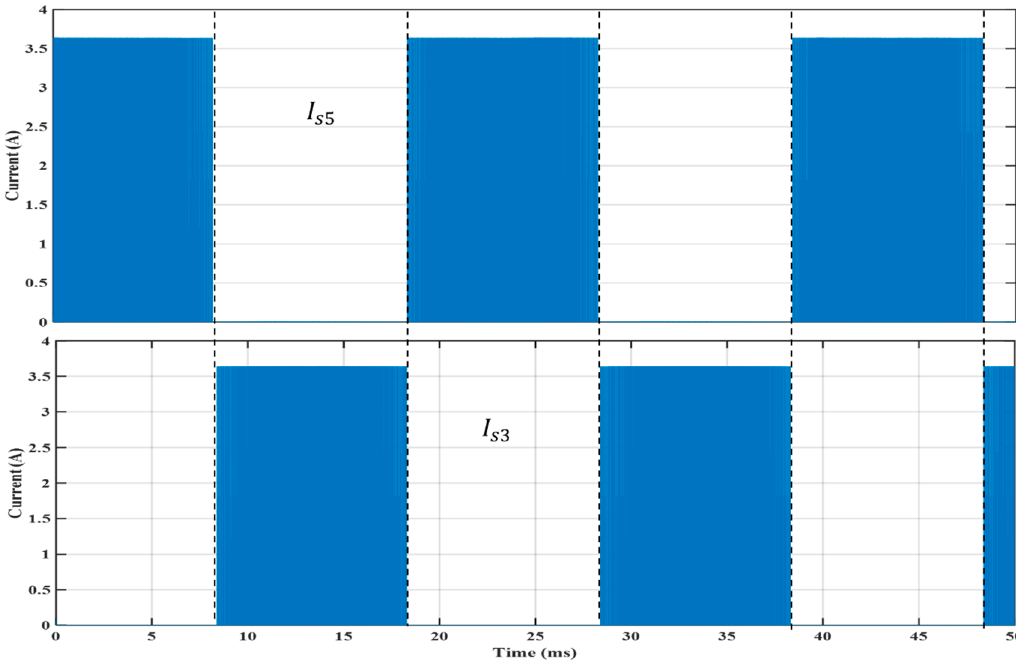
Figure 5. Currents of switches 𝑆 (cid:2873) and 𝑆 (cid:2871) of the PWM converter.